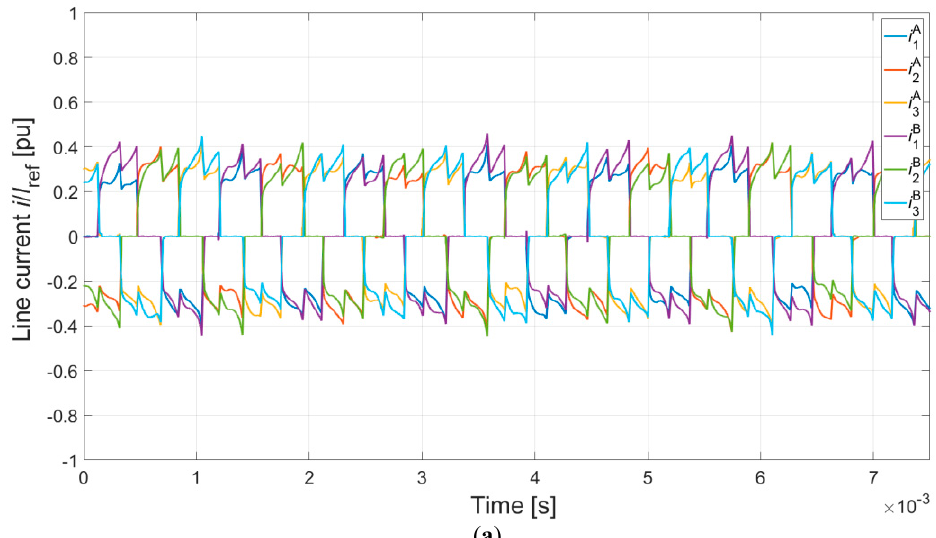
Figure 7 . Relative electromagnetic torque and line currents in DCO and SCO modes of the DCBLDCM and the DCSRM at high speed. ( a ) Electromagnetic torque T e for the DCBLDCM. ( b ) Line currents for the DCBLDCM. ( c ) Electromagnetic torque T e for the DCSRM. ( d ) Line currents for the DCSRM.